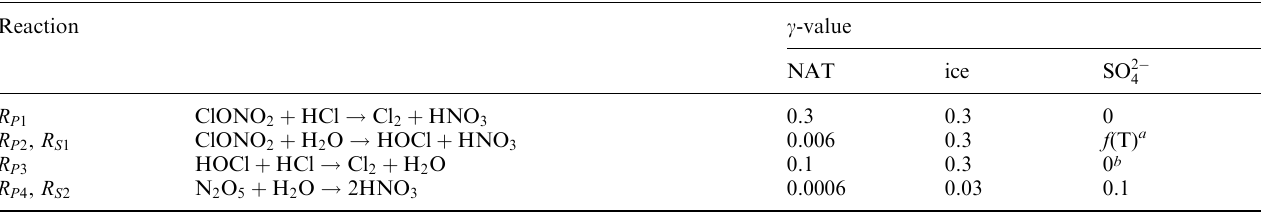
(cid:129)(cid:129)(cid:129)(cid:129)(cid:129)(cid:129)(cid:129)(cid:129)(cid:129)(cid:129)(cid:129)(cid:129)(cid:129)(cid:129)(cid:129)(cid:129)(cid:129)(cid:129)(cid:129)(cid:129)(cid:129)(cid:129)(cid:129)(cid:129)(cid:129)(cid:129)(cid:129)(cid:129)(cid:129)(cid:129)(cid:129)(cid:129)(cid:129)(cid:129)(cid:129)(cid:129)(cid:129)(cid:129)(cid:129)(cid:129)(cid:129)(cid:129)(cid:129)(cid:129)(cid:129)(cid:129)(cid:129)(cid:129)(cid:129)(cid:129)(cid:129)(cid:129)(cid:129) T (cid:255) 188 (cid:255)(cid:133) p H 2 O (cid:255) 5 (cid:2) 10 (cid:255) 4 (cid:134) = 6 : 9 (cid:2) 10 (cid:255) 5 3 85